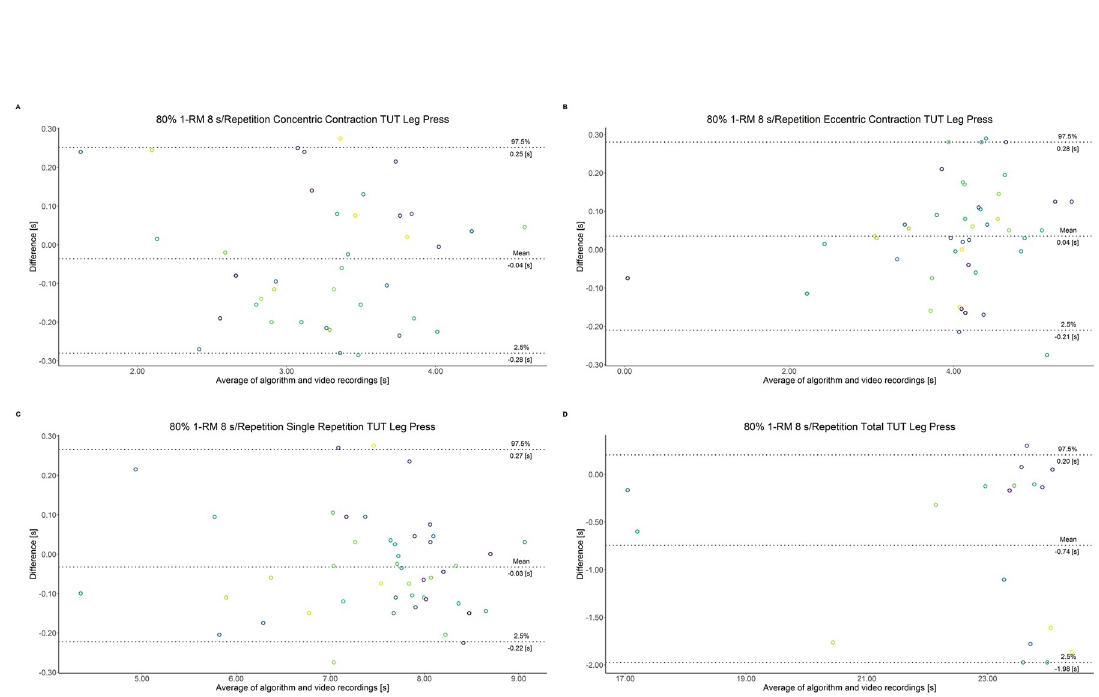
Fig 18. Bland-Altman plots of agreement between algorithmically accelerometer derived and video recordings derived contraction-specific phases of the leg press machine at 80% 1-RM with a velocity of 8 s per repetition. A: Concentric contraction phase. B: Eccentric contraction phase. C: Single repetition. D: Total time-under-tension.